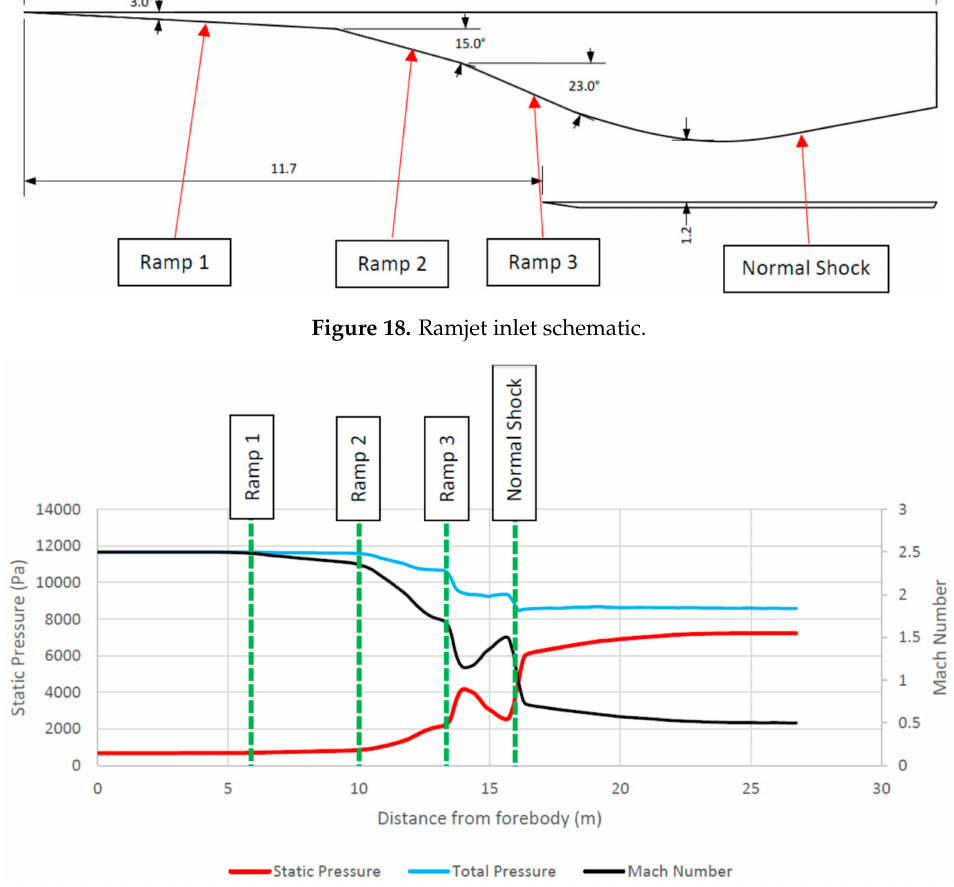
Figure 19. Performance of ramjet inlet at Mach 2.5 (50,000